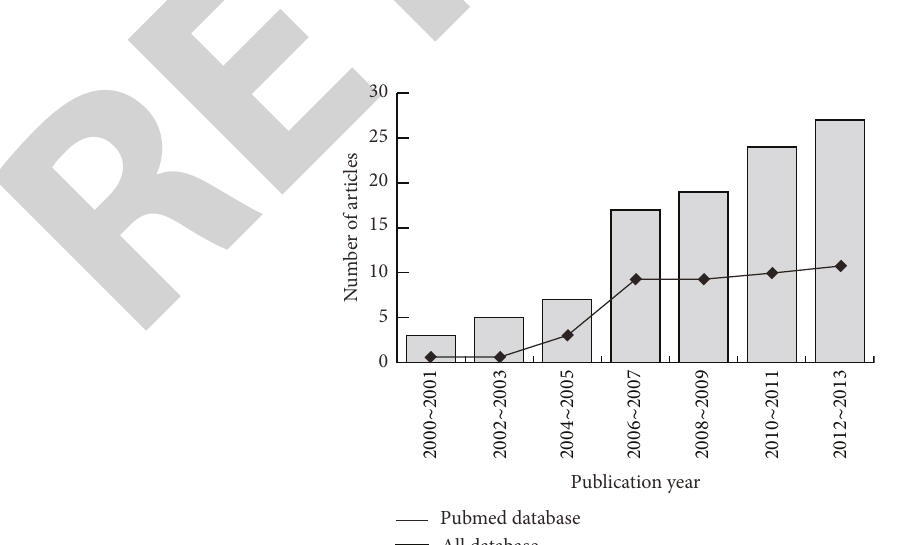
Figure 2: The distribution of the number of topic-related literatures in the electronic database during the last